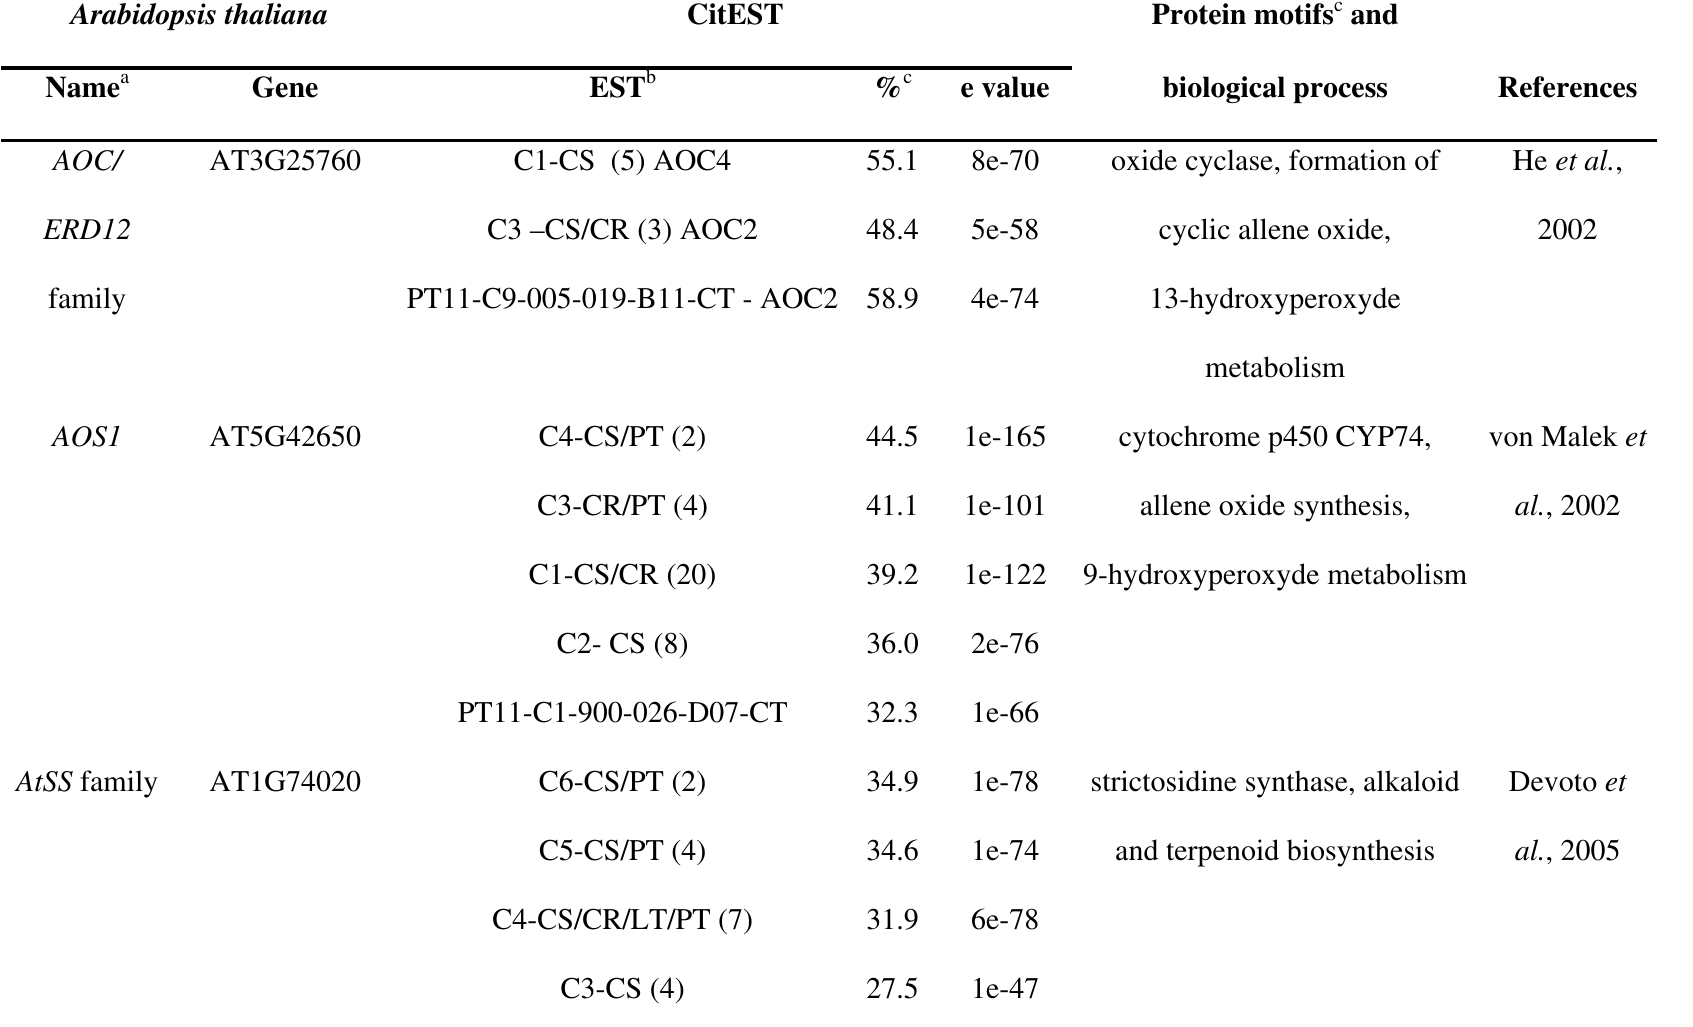
Table S11 – Citrus ESTs with homology to genes involved in jasmonic acid biosynthesis in Arabidopsis thaliana . Arabidopsis